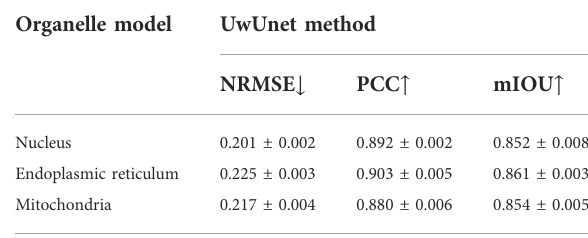
TABLE 3 The prediction result measure of protein subcellular localization using the UwUnet